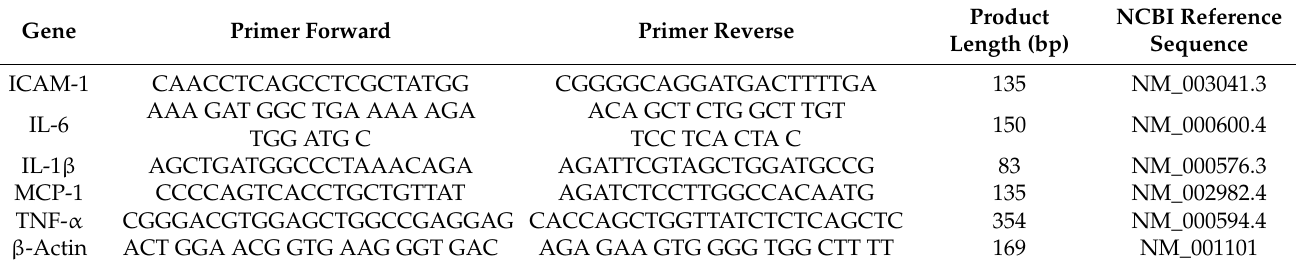
Table 1. Primer used for PCR